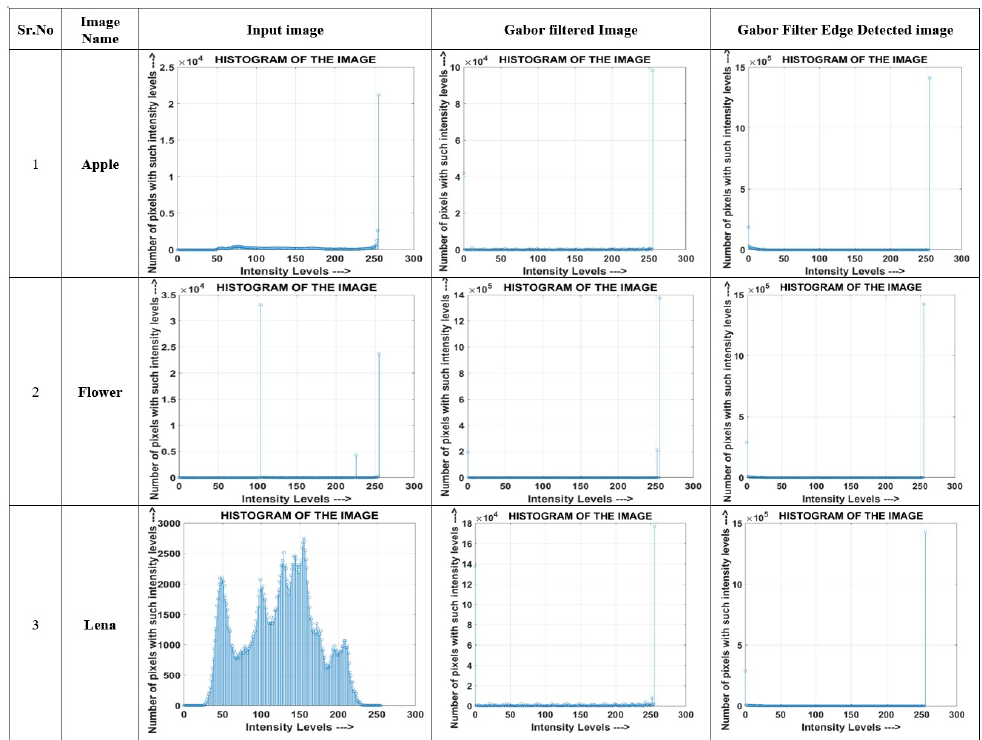
Figure 7. Histogram for original image, Gabor filtered image and the image after Edge detection. X label in each histogram: intensity level; Y label in each histogram: number of pixels against the intensity level.